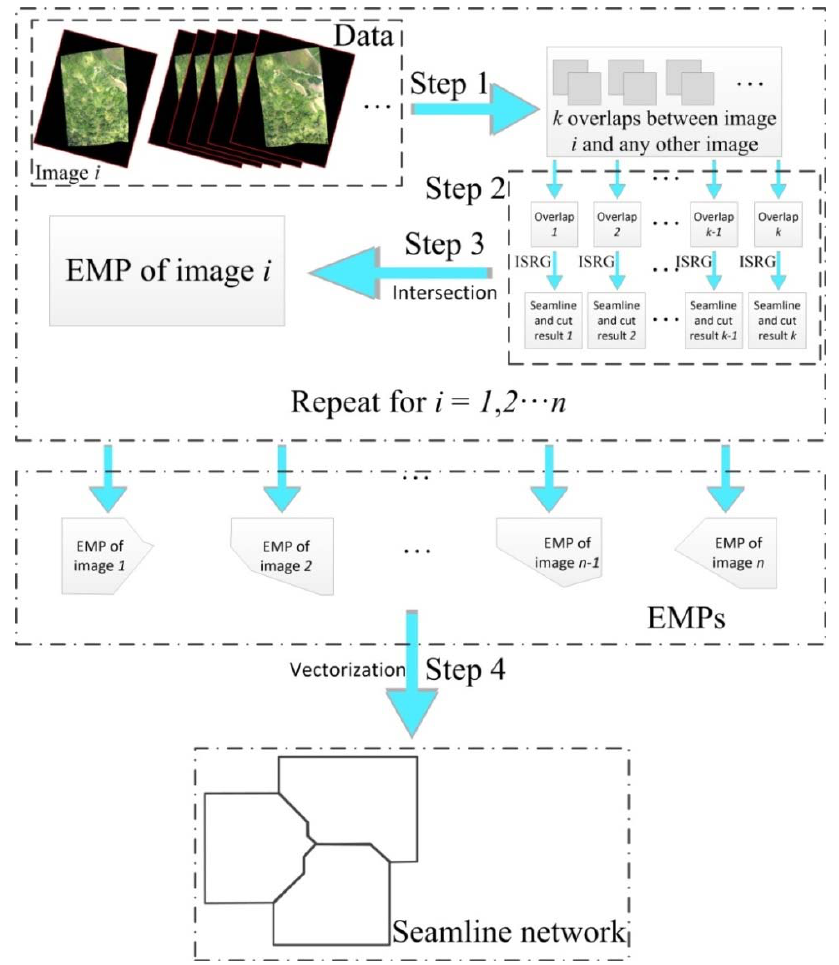
Figure 1. The flowchart of the improved seeded region growing-based seamline network generation method. ISGR: improved seeded region growing algorithm; EMP: effective mosaic polygon. method. ISGR: improved seeded region growing algorithm; EMP: effective mosaic